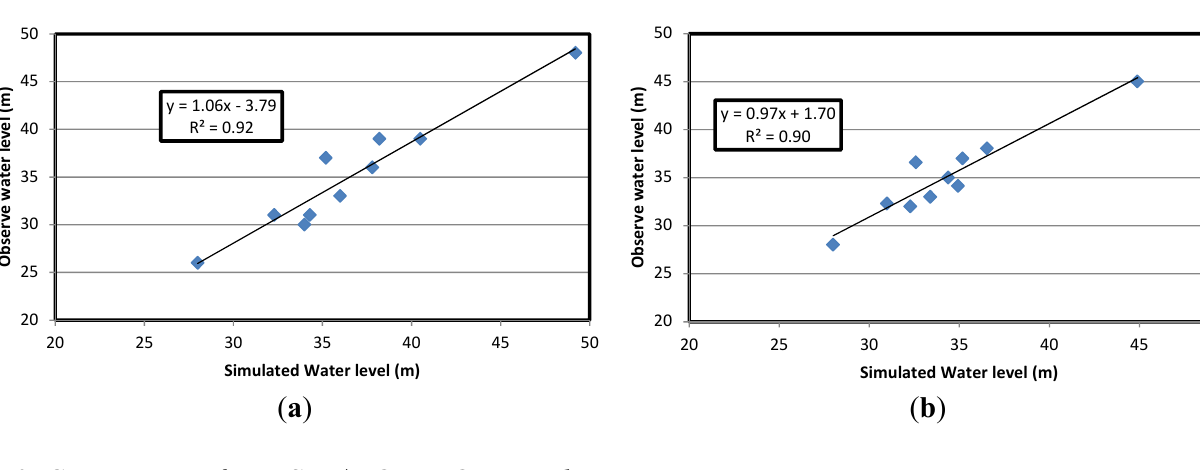
Figure 10. ( a ) Simulated water table vs. observed water table for the calibration period. ( b ) Simulated water table vs. observed water table for the validation